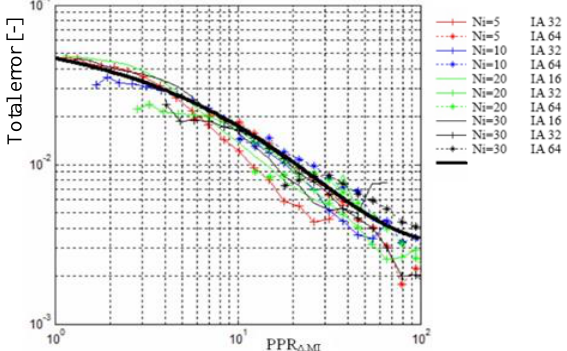
Fig. 5. Influence of seeding density and interrogation area size for PPR∆.MI .